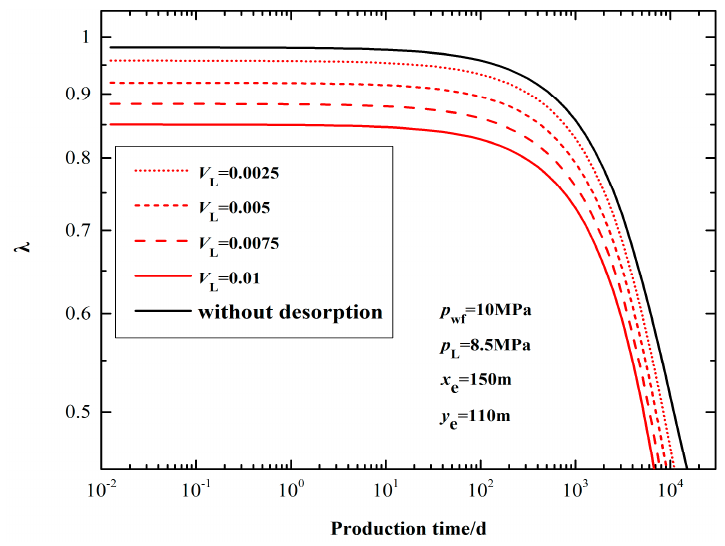
Figure 10. Effect of Langmuir volume on pseudo-time variable λ ( t ).